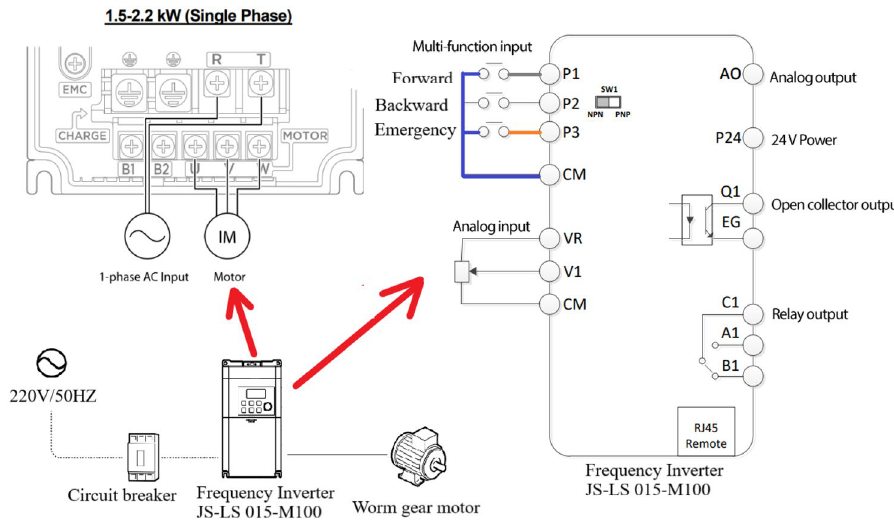
Fig. 9 Electrical diagram of the plastic shredder machine